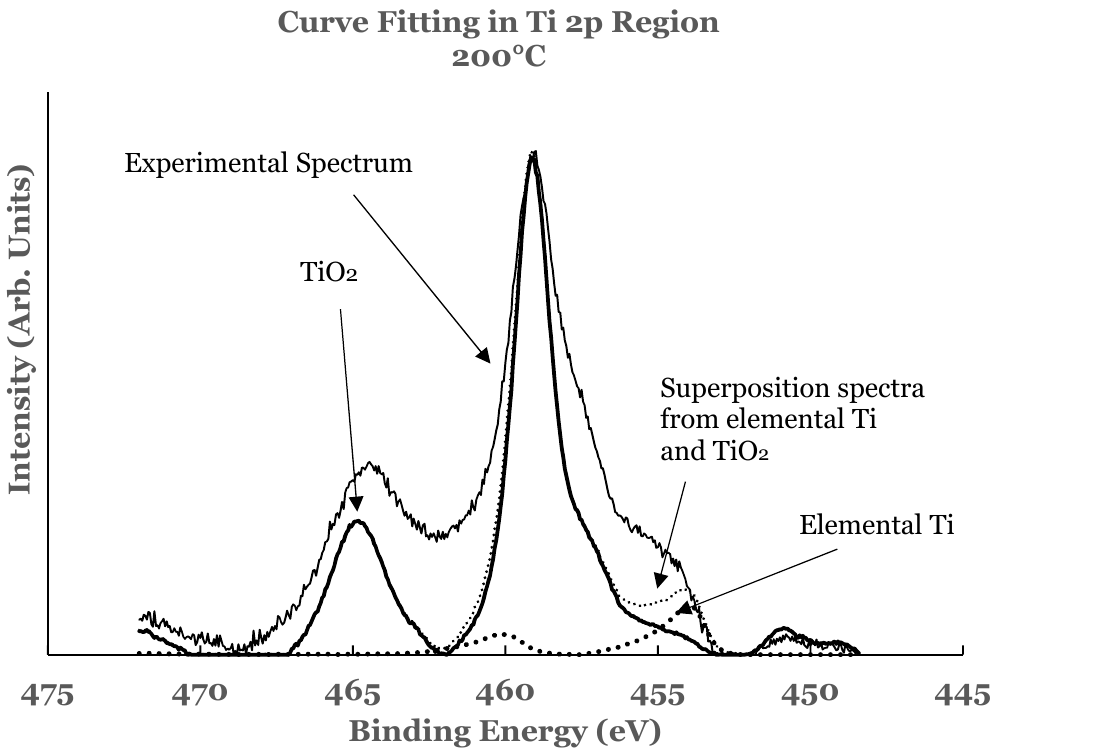
Figure 10. Curve fit for titanium for the 1.1 nm overlayer deposited at 200 °C substrate temperature. The thin solid line represents the experimental data. The thick dotted line represents the spectrum from elemental Ti while the thick solid line that from TiO 2 . The thin dotted line represents the superposition from elemental Ti and TiO 2 .